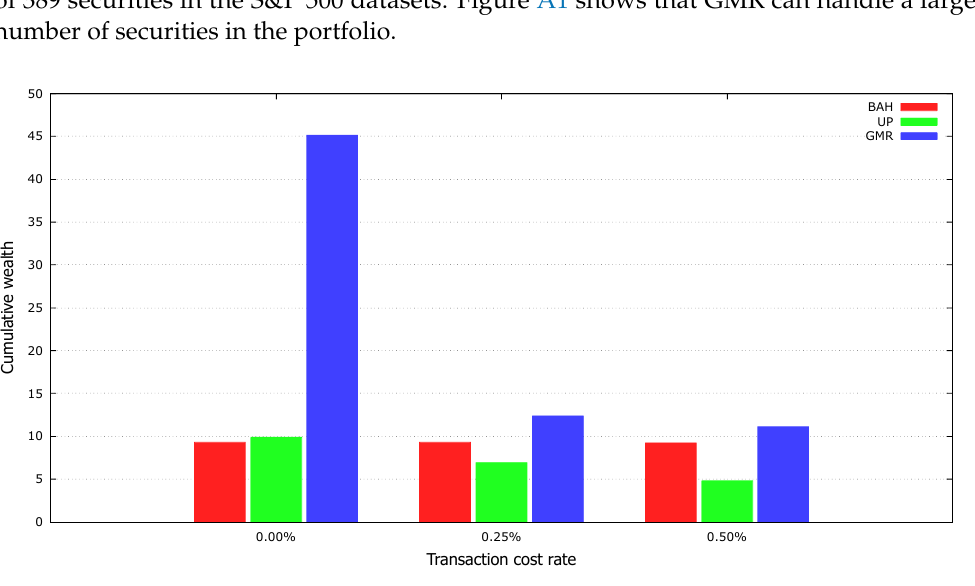
Figure A1. Cumulative wealth on the portfolio of 389 stocks according to the rate of transaction